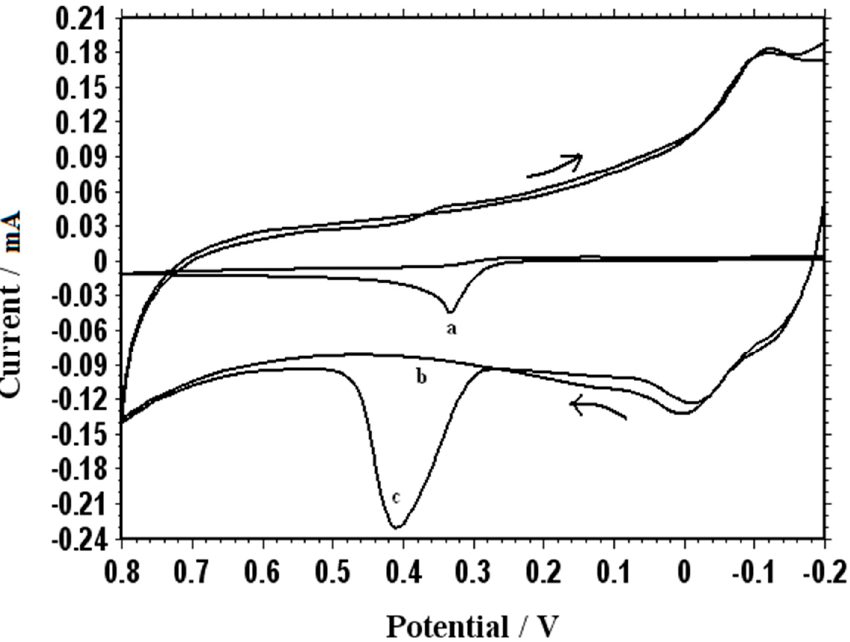
Figure 8. Cyclic voltammogram of the BCPE in 1 mM uric acid (UA) is shown in Curve a. Curves b and c respectively show the cyclic voltammograms of the PMCPE in a blank buffer solution and in 1 mM UA (curve c) at 100 mV ∙ s − 1 in 0.1 M PBS (pH 7.0).